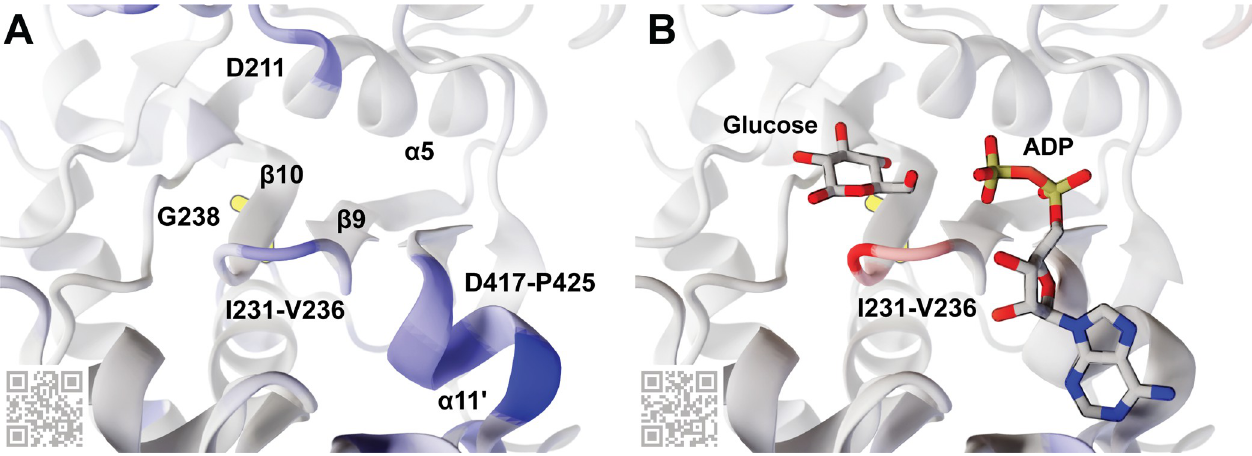
Fig 6. An Hxk2 pocket conformation taken from the MD simulations. G238, though largely obscured by the β 10 strand, is shown in yellow sticks. Other key amino acids, molecules, and secondary-structure elements are labeled. The Hxk2 protein (ribbon) is colored according to the calculated Δ RMSF values, where blue indicates that the G238V simulation was more flexible ( Δ RMSF > = 0.85 Å ), and red indicates that the WT simulation was more flexible ( Δ RMSF < = -0.85 Å ). (A) The Δ RMSF values for the apo (ligand-absent) simulations. (B) The Δ RMSF values for the holo (glucose-bound) simulations. Glucose and ADP crystallographic poses are superimposed only for reference, to indicate the locations of the glucose and ATP-binding pockets. They were taken from structures of Hs HK1 (human, PDB 4FPB) and Os HXK6 (rice, PDB 6JJ8), respectively. QR codes encode ProteinVR URLs for visualization in stereoscopic 3D (virtual reality). See also Tables A and B in S1